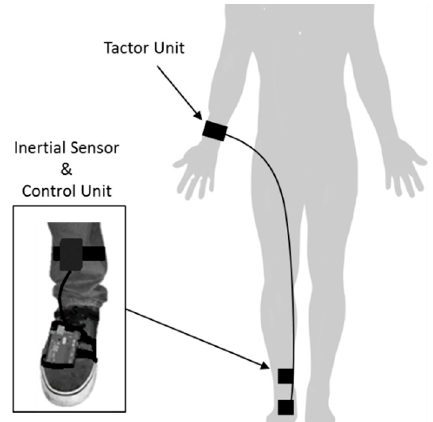
Figure 17. Illustration of a user wearing the continuous somatosensory cueing device VibroGait, developed by Mancini et al. A haptic drivers/vibration unit was placed on wrist and connected to a control unit and inertial sensor.